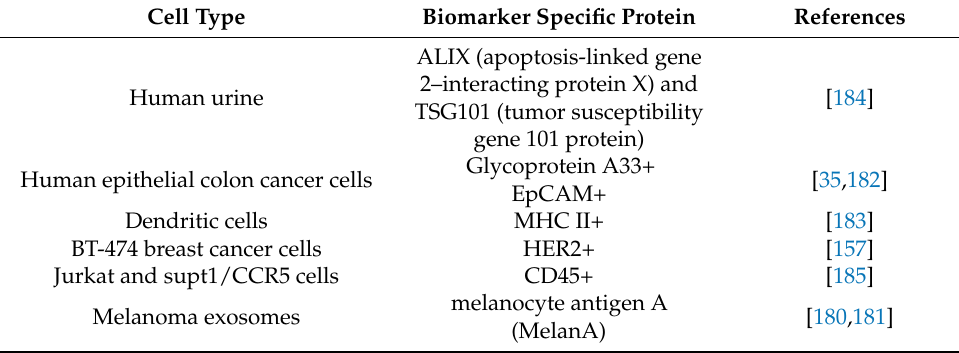
Table 5. Biomarkers of specific proteins in exosomes according to cell